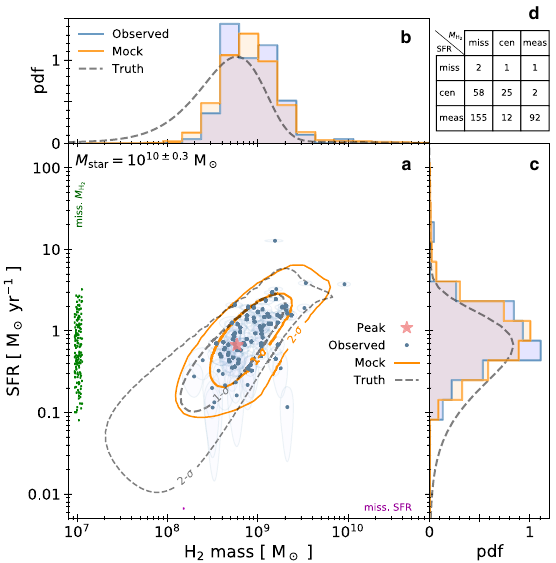
Figure 3 highlights two important points. First, the probability distributions of the observational data are well reproduced by the fi ducial model after selection effects and observational uncertainties are taken into account. This shows that the underlying model provides a good description of the observational data. Secondly, there is a clear difference between the apparent ( “ mock ” ) and the actual ( “ true ” ) distribution of the model data thus highlighting the importance of properly modeling measurement uncertainties and data censoring in observational data. Here, data censoring refers to measurements that have been carried out but return values below a detection limit. The apparent relation between SFR and M steeper than the actual relation as galaxies with low molecular masses are more likely to be censored than those with low SFRs.